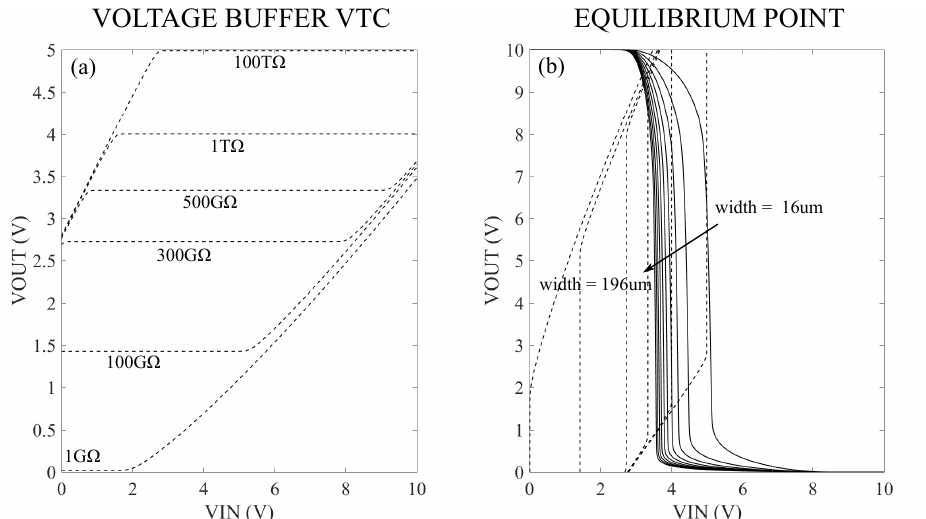
Figure 10. Compensation of the input offset in HV-process (AMS-H35, nmos20h/pmos20h). ( a ) Voltage buffer VTC curve for different value of R C . ( b ) Equilibrium point for different width of the NMOS in the inverter and for different R C